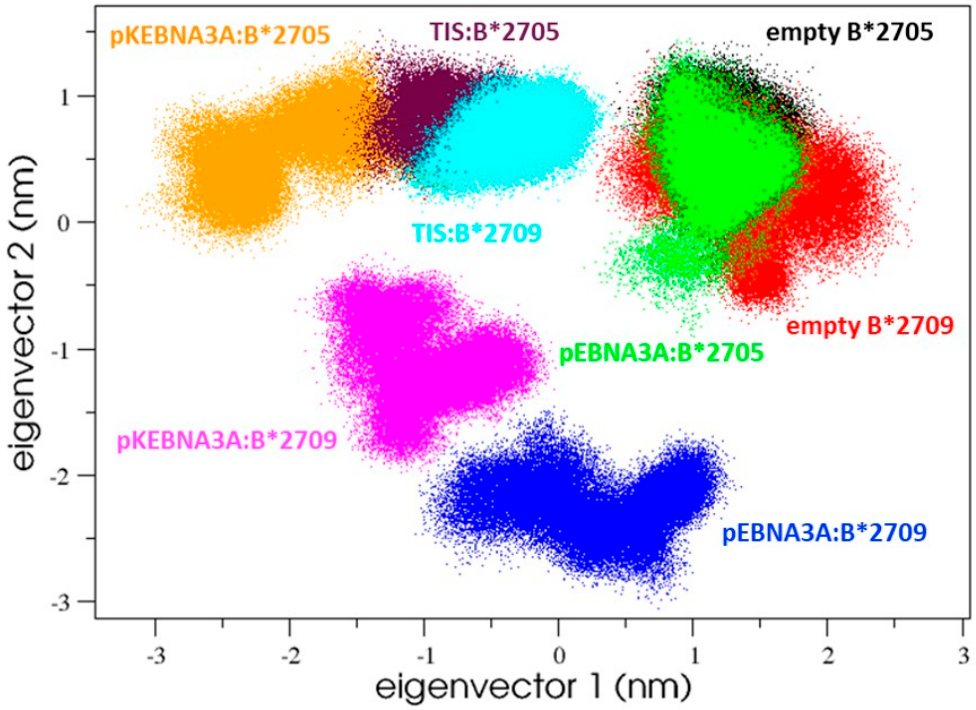
Figure 4. C-alpha binding-groove projections on their common essential subspace, highlighting four main regions featured by: (1) the empty HLA-B*2705 / 09 and pEBNA3A:B*2705; (2) pKEBNA3A:B*2705 and TIS:B*2705 / 09; (3) pEBNA3A:HLA-B*2709; (4) pKEBNA3A:HLA-B*2709 complexes. Each point represents a structure sampled by MD simulation.